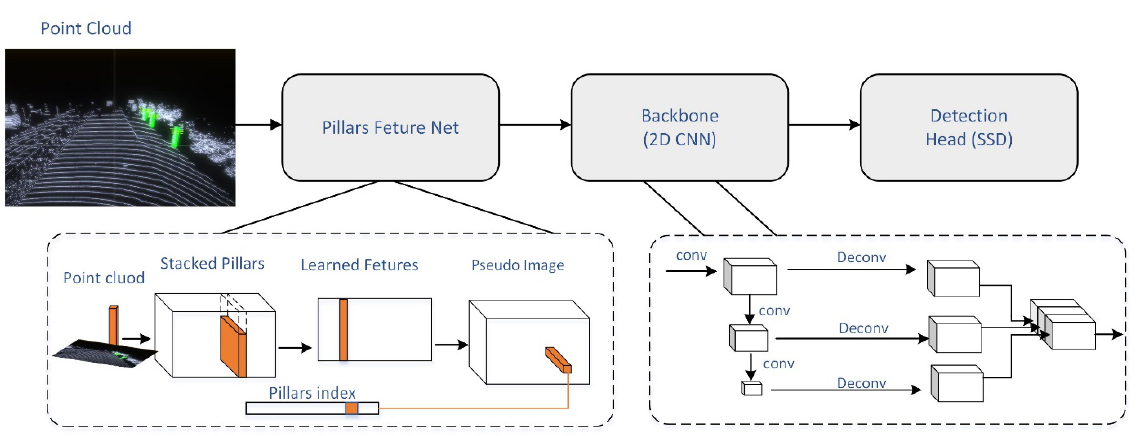
Figure 1. PiontPillars network overview.